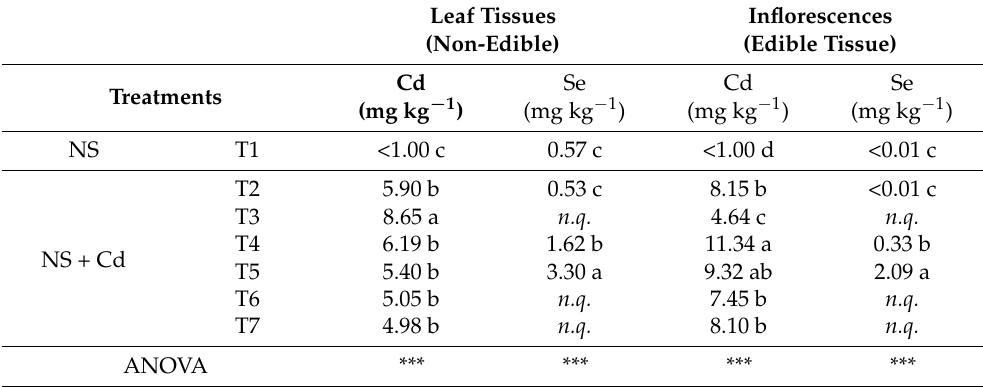
Table 4. Concentration of Cd and Se quantified at the end of the experiment if leaf tissues (non- edible) and in the inflorescences (edible tissue) of broccoli plants grown under Cd toxicity con- ditions and treated with different active materials to mitigate this toxicity (T1: NS, T2: NS + Cd,